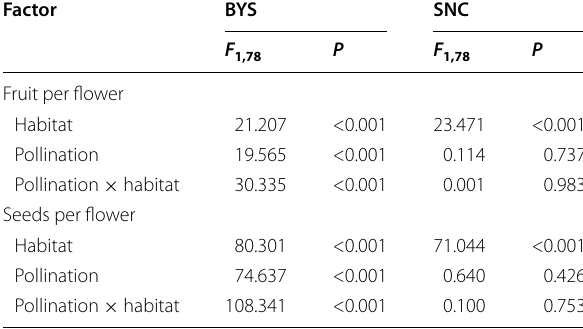
Table 3 Results of the linear mixed model test of the effects of habitat (forested vs. open patch) and pollination treatment (natural vs. supplemental) on fruit and seed production in the two populations of H .